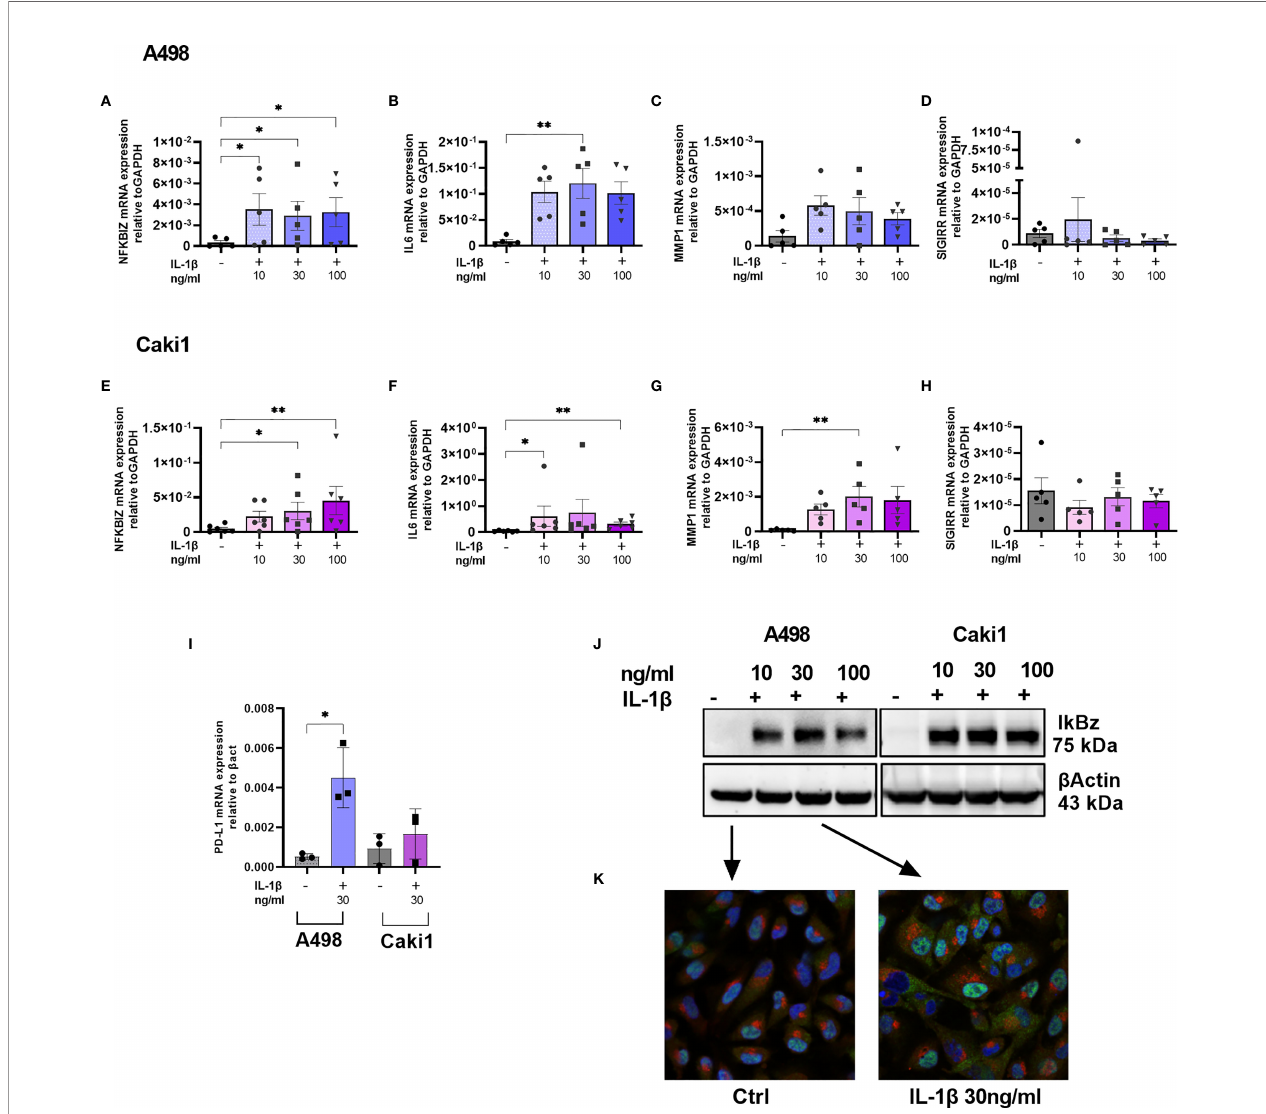
FIGURE 4 | IL1-mediated cell activation and immune evasion in RCC. NFKBIZ (A, E) , IL6 (B, F) , MMP1 (C, G) , SIGIRR (D, H) , and PDL1 (I) mRNA expression levels in A498 (A – D, I) and CAKI1 (E – H, I) cell lines with or without stimulation with increasing concentration of IL1 b (10 – 30 – 100 ng/ml) for 4 h were measured by qRT-PCR and expressed as mean ± SEM of at least fi ve independent experiments. *p < 0.05, **p < 0.01. (J) IkBz protein expression after IL1 b stimulation for 4 h in A498, and CAKI1 was assessed by Western blot analysis. B-Actin was used as loading control. (K) Representative confocal microscopy images of untreated and treated A498 cells with IL1 b 30 ng/ ml. IkBz protein in green, golgin in red, and 4,6-diamidino-2-phenylindole (DAPI) staining cell nuclei in blue (original magni fi cation